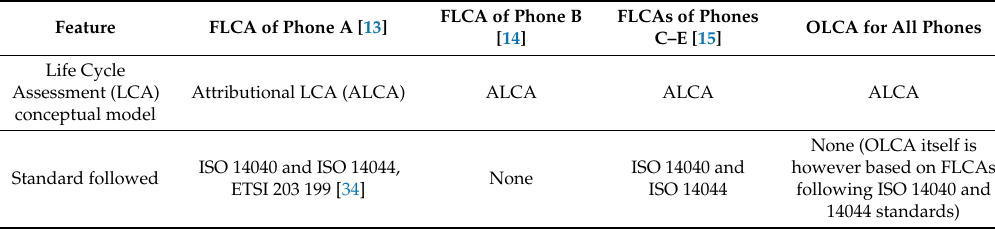
Table 1. Main characteristics of Full Life Cycle Assessment (FLCA) studies and Open Eco Rating LCA (OLCA)